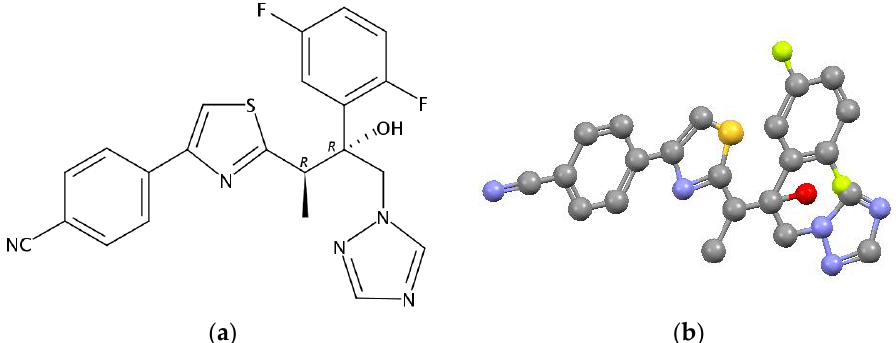
Figure 1. Chemical structure ( a ) and three-dimensional representation ( b ) of IVZ.